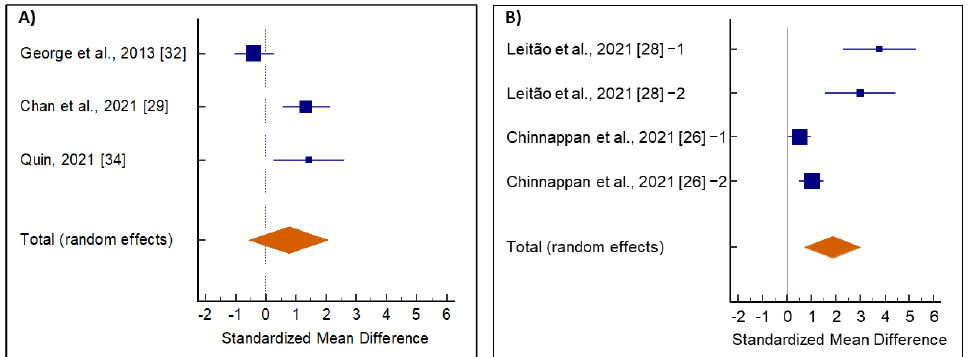
Figure 4. Average net change in serum testosterone levels of ( A ) normal healthy men and ( B ) men with hypogonadism supplemented with Eurycoma longifolia . The pooled effect size is indicated by the diamond.